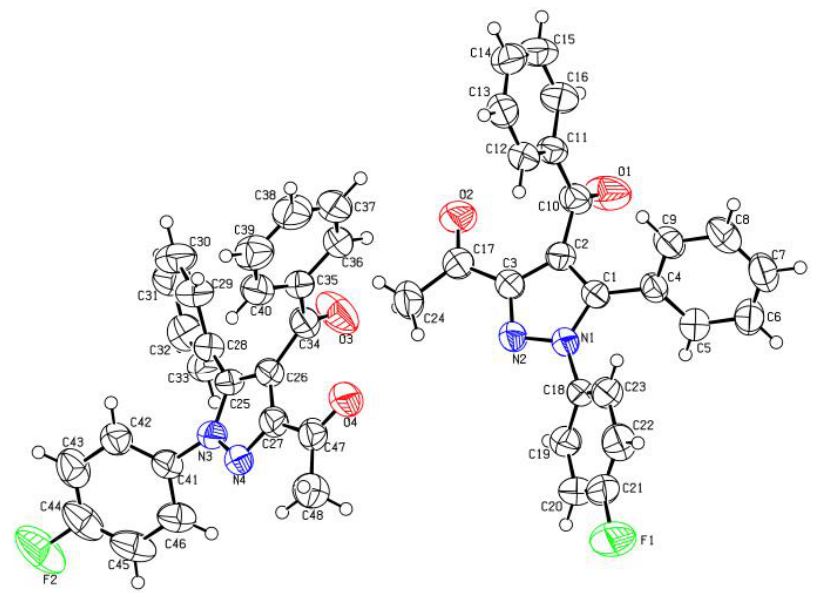
Figure 3. Single-crystal X-ray of compound 3c .